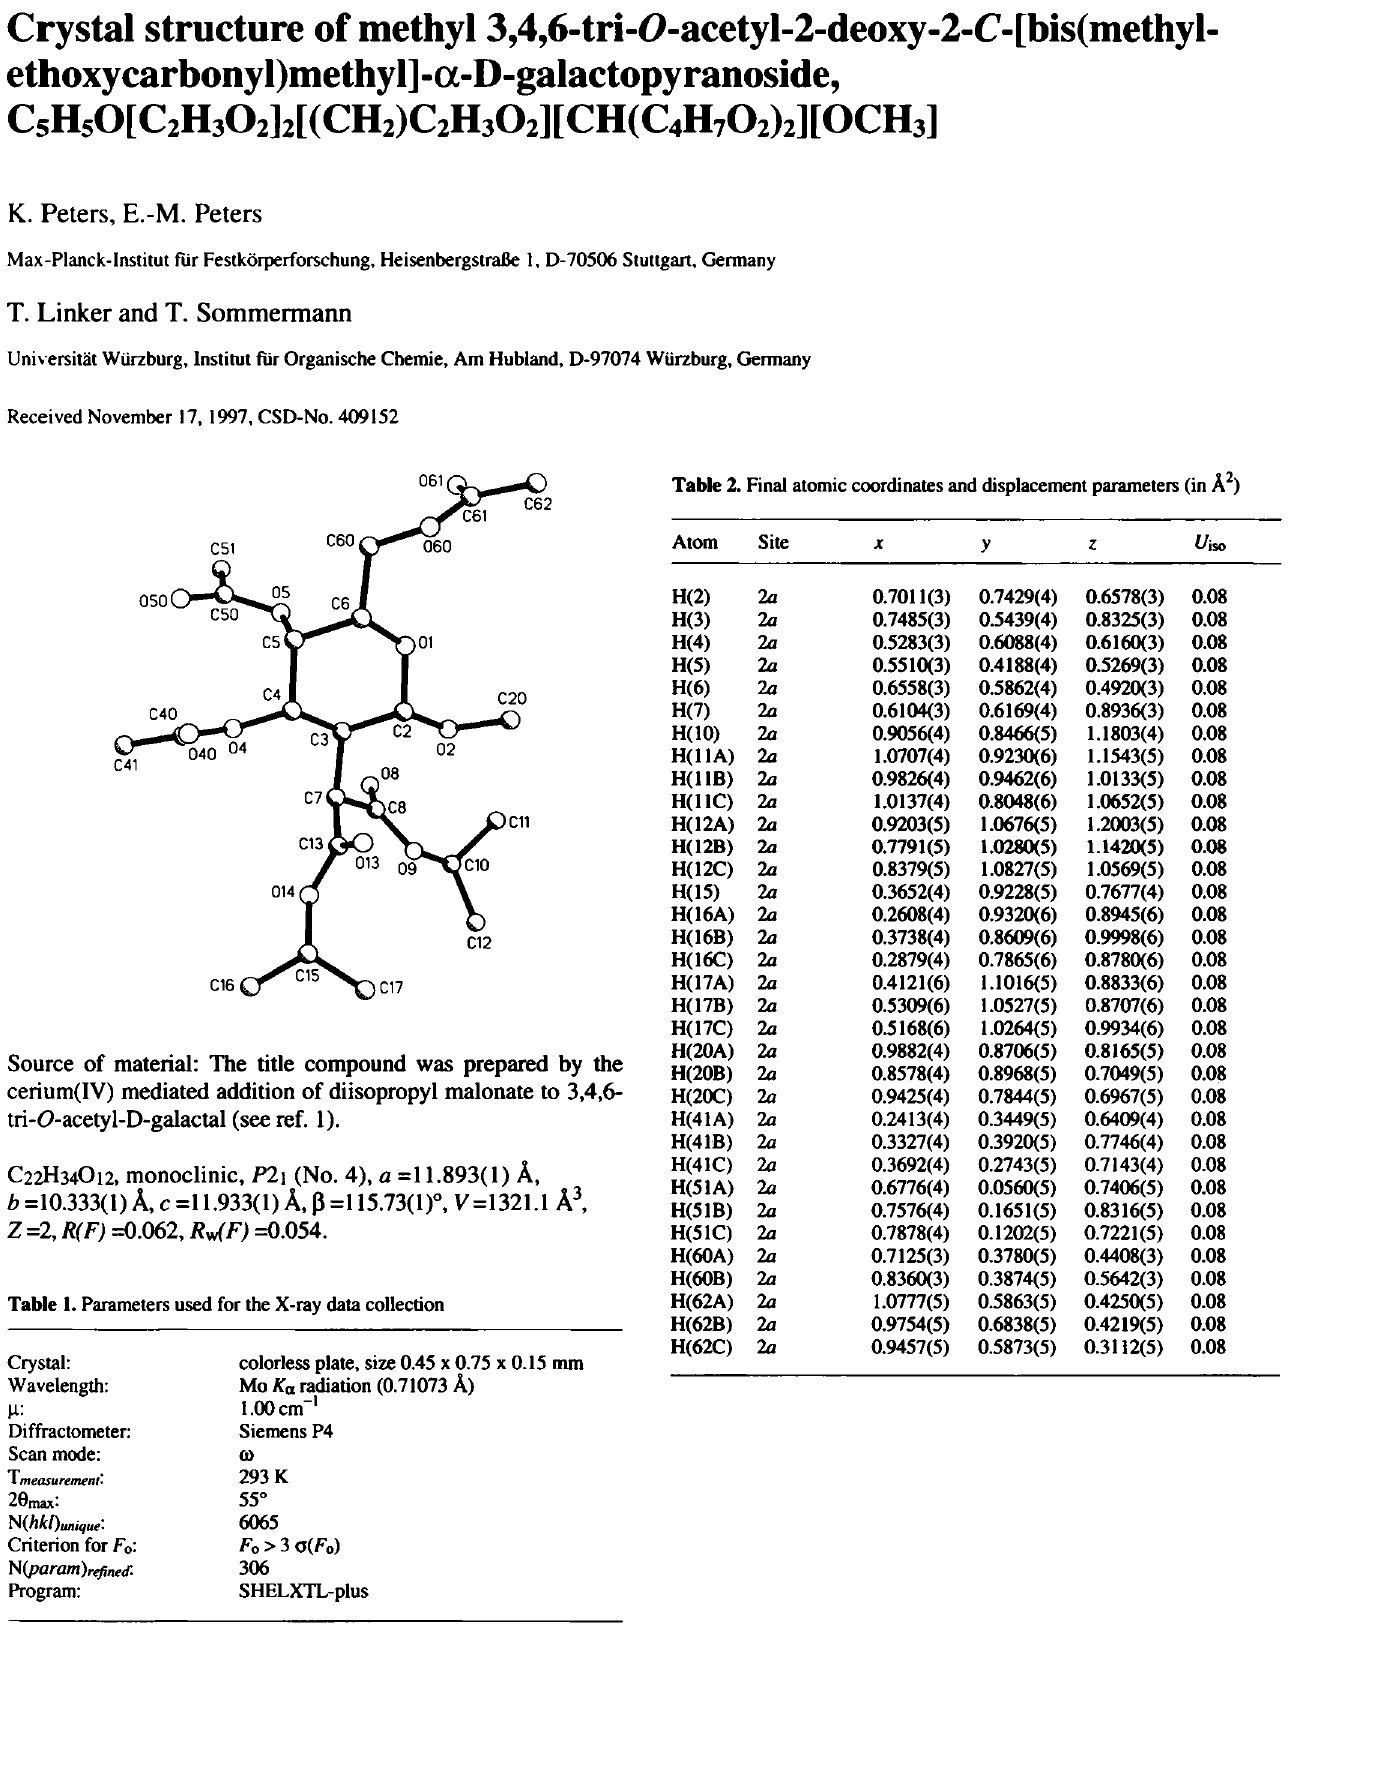
Table 2. Final atomic coordinates and displacement parameters (in Â^)